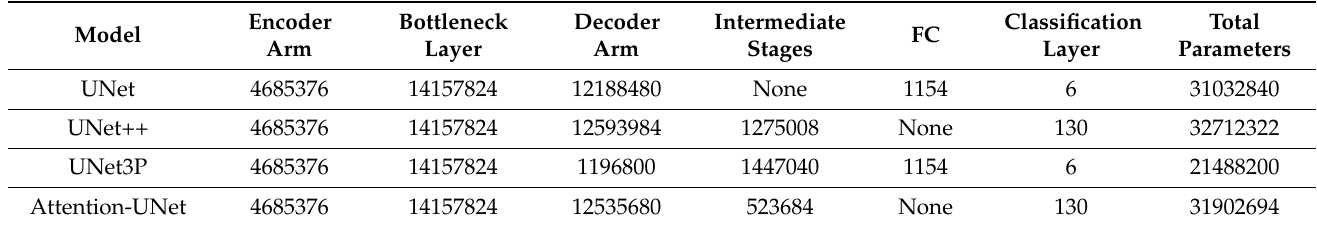
Table 2. Number of trainable parameters in different parts of the UNet architectures.